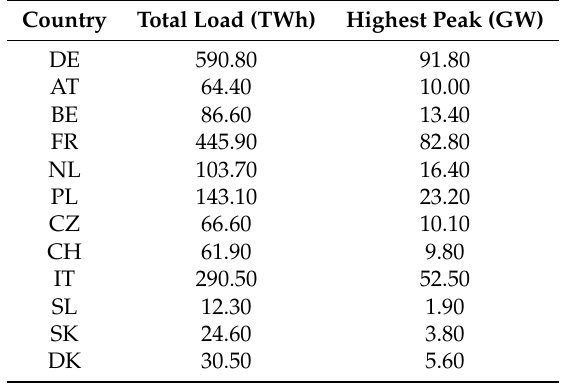
Table 3. Total load and highest peak for each country in 2013.